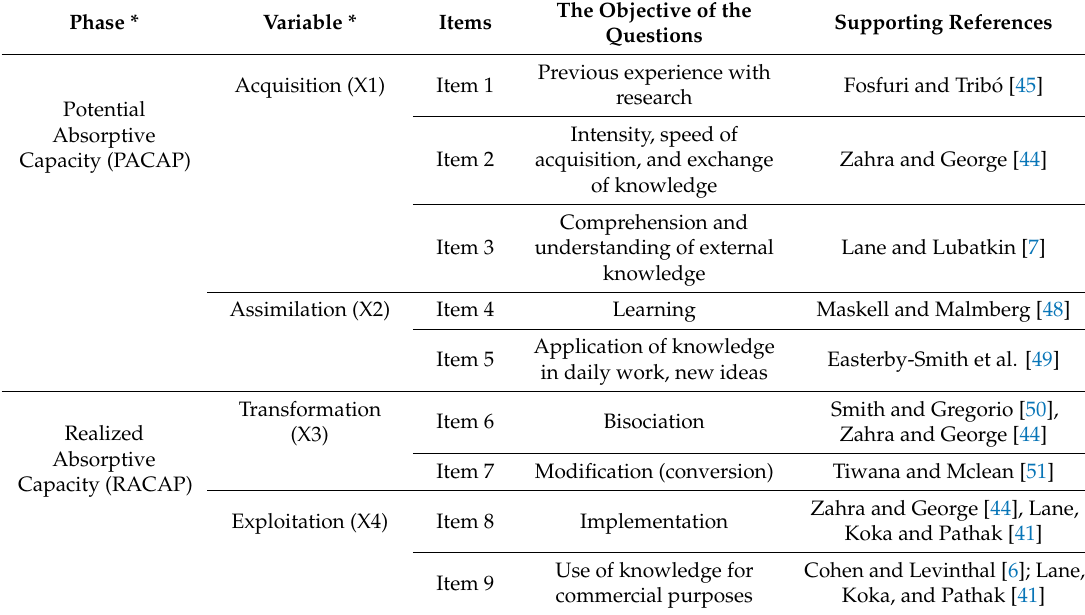
Table 1. Operationalization of the variables, items, objectives, and